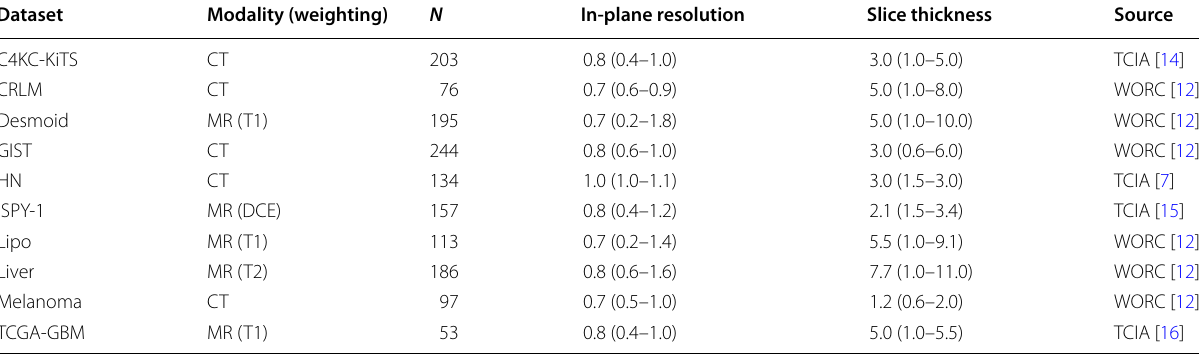
For MR imaging, the used weighting is reported in parenthesis; N denotes the number of samples; and in-plane resolution and slice thickness are reported as median and range